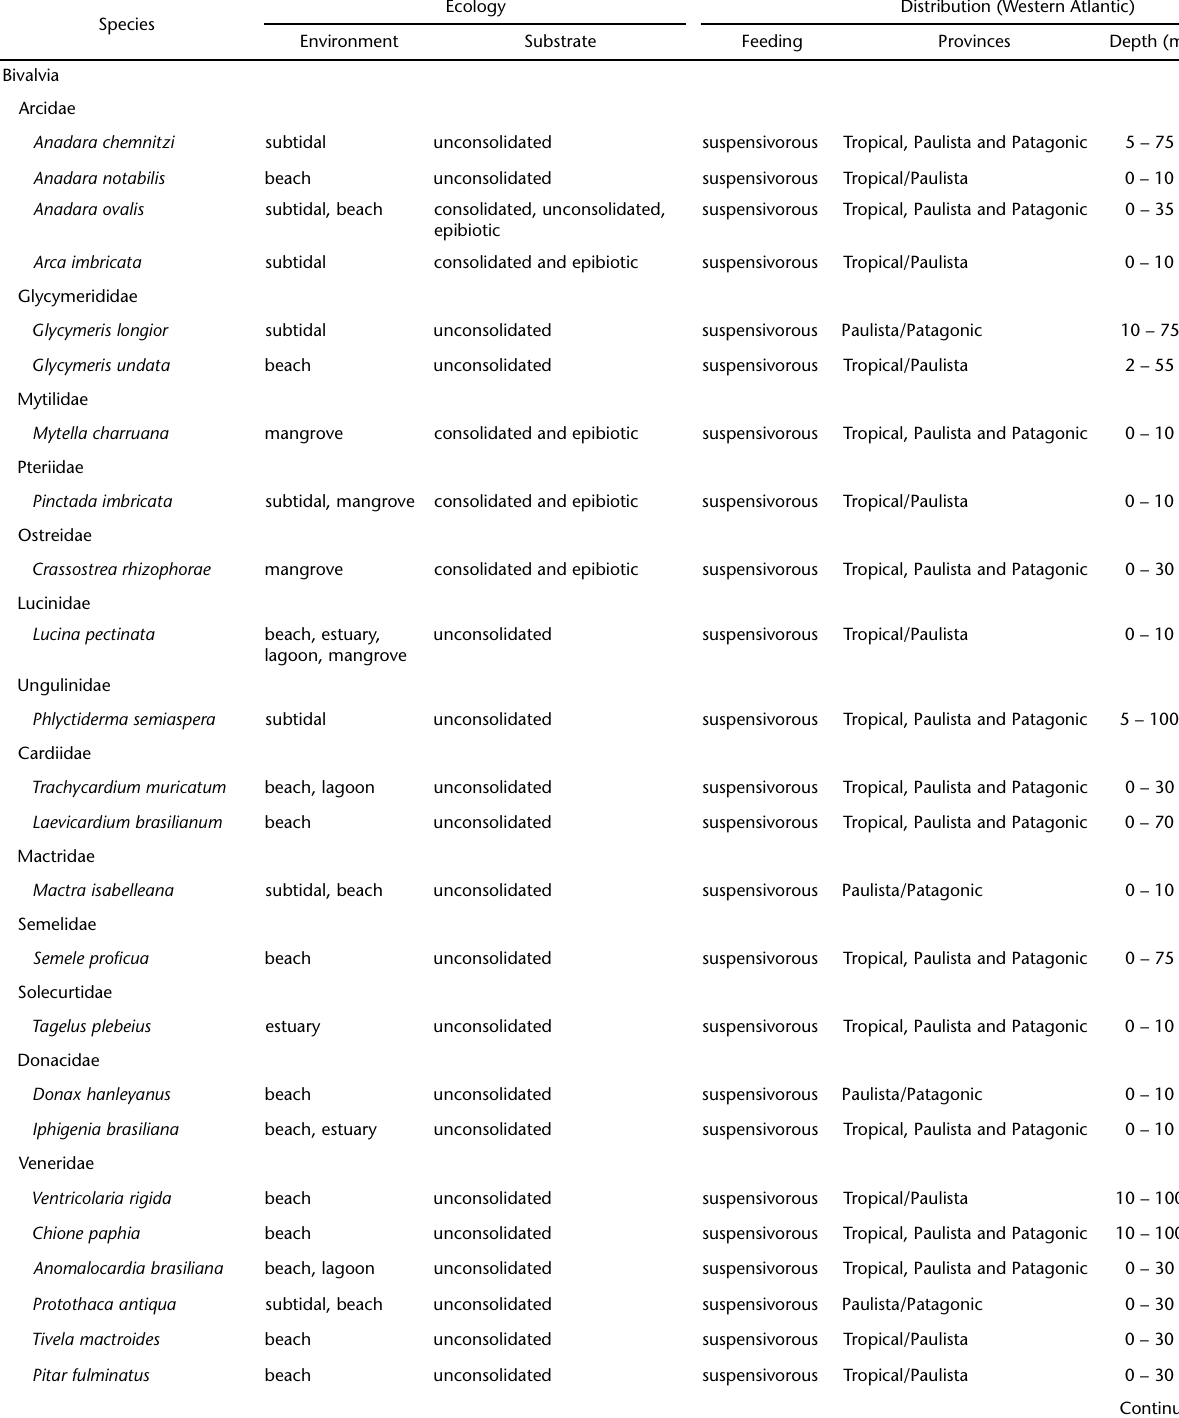
Table I. Inventory of the mollusk fauna at Sambaqui da Tarioba. The category Environment in the table presents obtained information about depth, habitats and marine systems. Ecology Distribution (Western Atlantic) Species Environment Substrate Feeding Provinces Depth